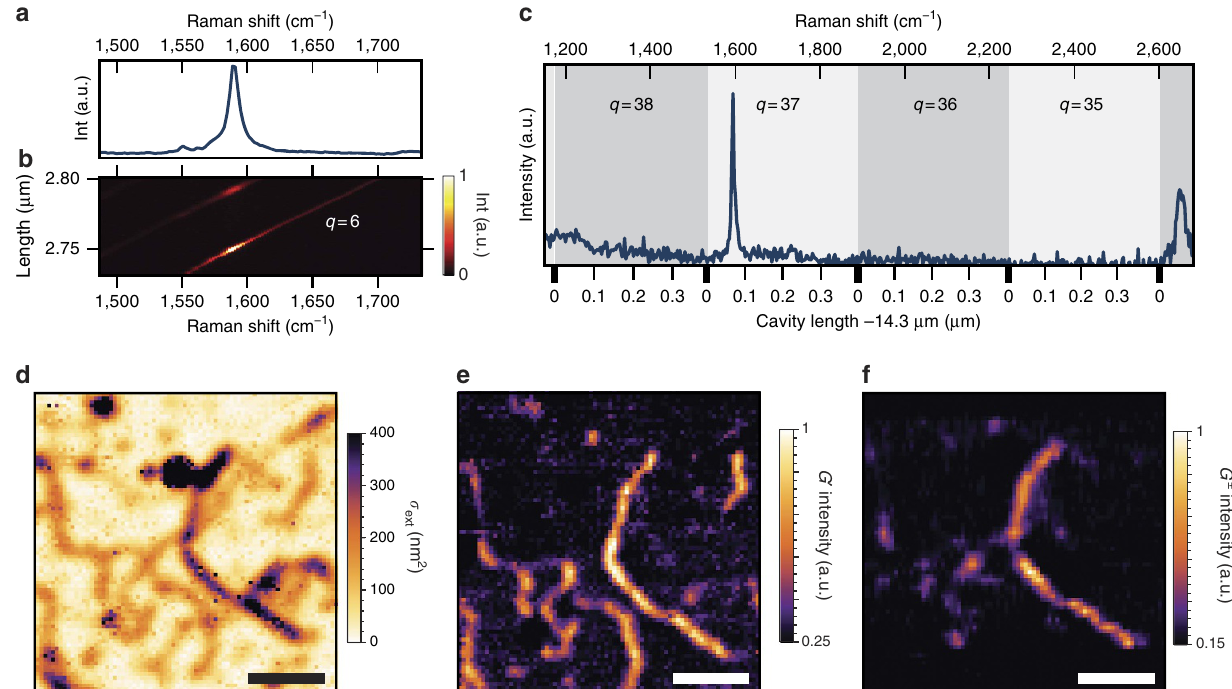
Figure 2 | Cavity-enhanced absorption and Raman imaging. ( a , b ) Acquisition of a Raman spectrum by tuning a cavity resonance across a spectral range around the G ± band and combining individual exposures. ( b ) Each horizontal line corresponds to an individual spectrum acquired for a particular cavity length. The strong line shows the tuning of the fundamental mode, the second weaker line corresponds to the first higher transverse mode of the cavity. ( a ) Spectrum obtained by taking the maximum of all exposures for each spectral position. ( c ) Broadband spectrum covering the G ± and G 0 band at 1,590cm (cid:2) 1 and 2,650cm (cid:2) 1 respectively. The differently shaded areas depict the range which individual longitudinal cavity modes cover at a mirror separation of 14.3 m m. ( d ) Scanning-cavity microscopy of the extinction cross-section s ext of isolated CNTs. ( e , f ) Raman hyperspectral imaging of the same area showing selectively the strength of the G 0 and the G ± band, respectively. Scale bars, 20 m